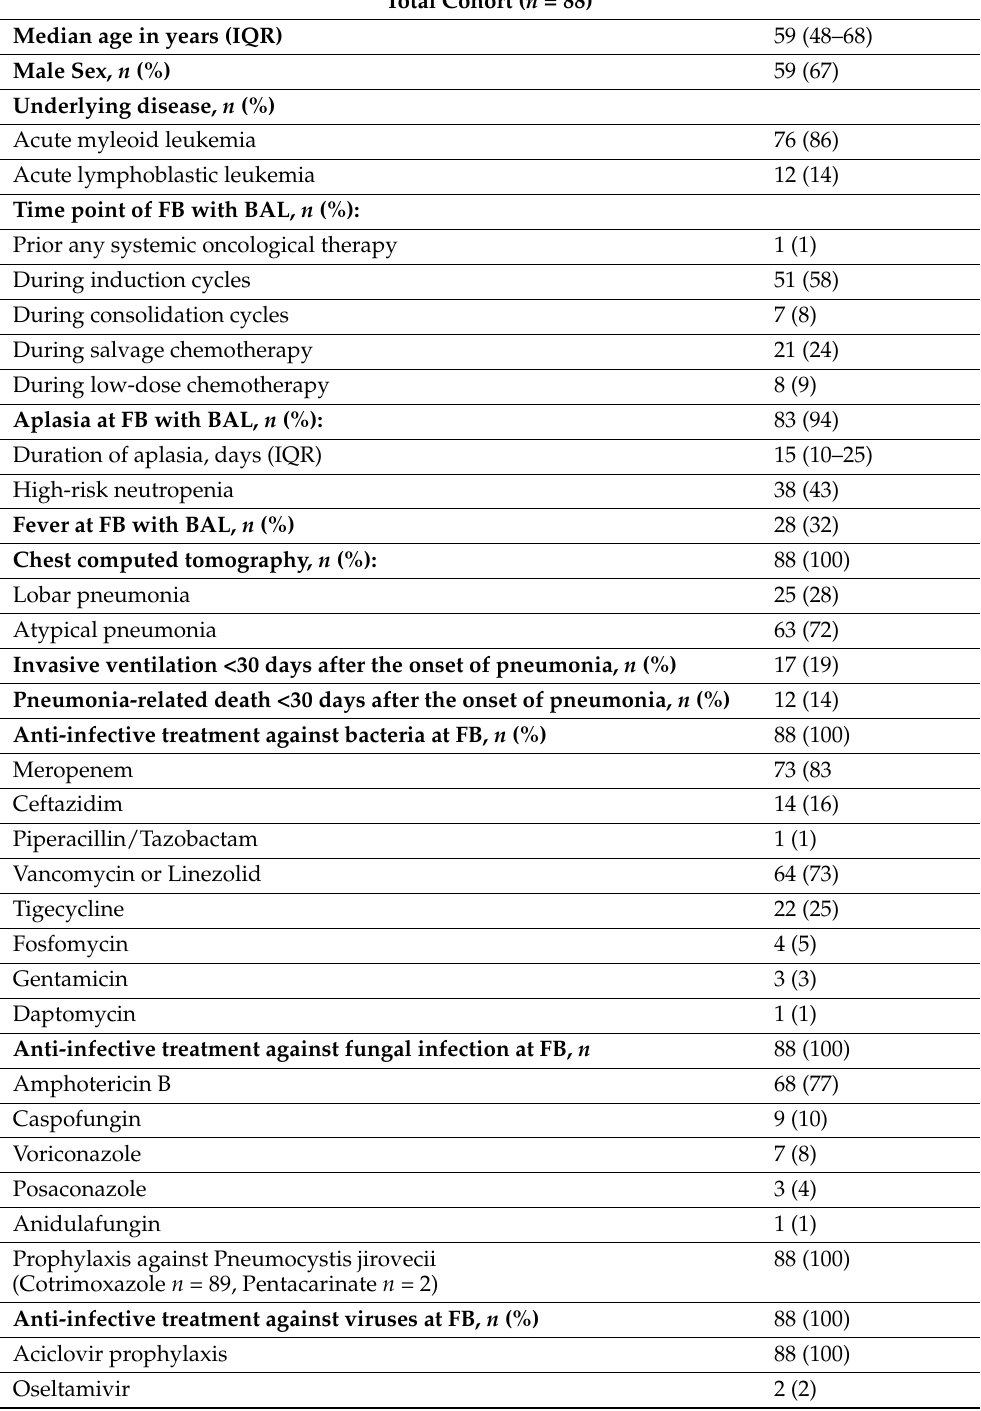
Table 1. Overview of patient characteristics and anti-infective